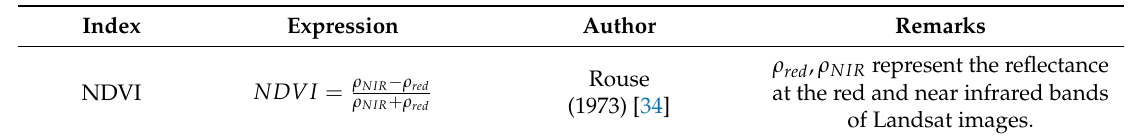
Table 3. Selected Vegetation